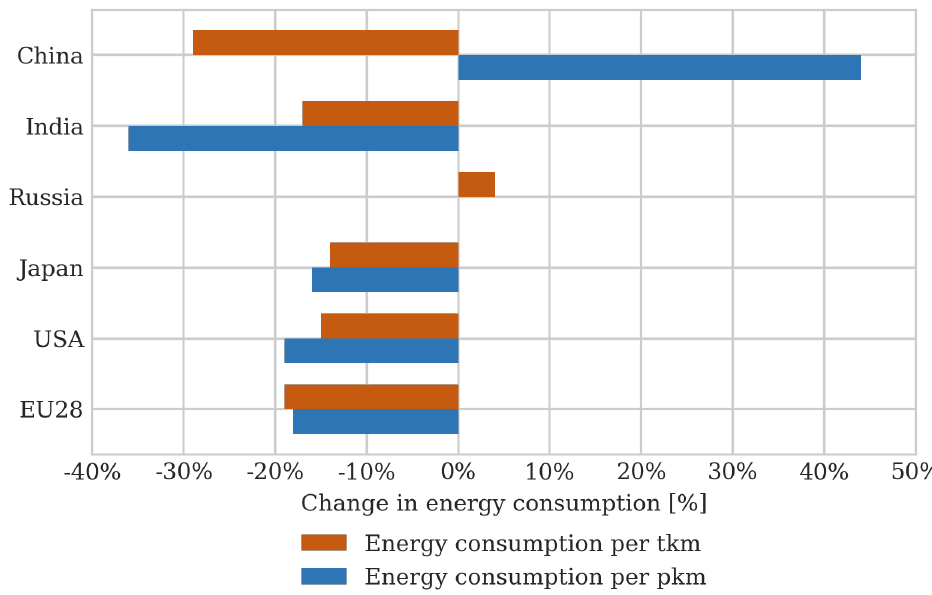
Figure 4. Change of unit energy consumption in the rail industry in selected regions in 2015 vs. 2005. Own study based on data from